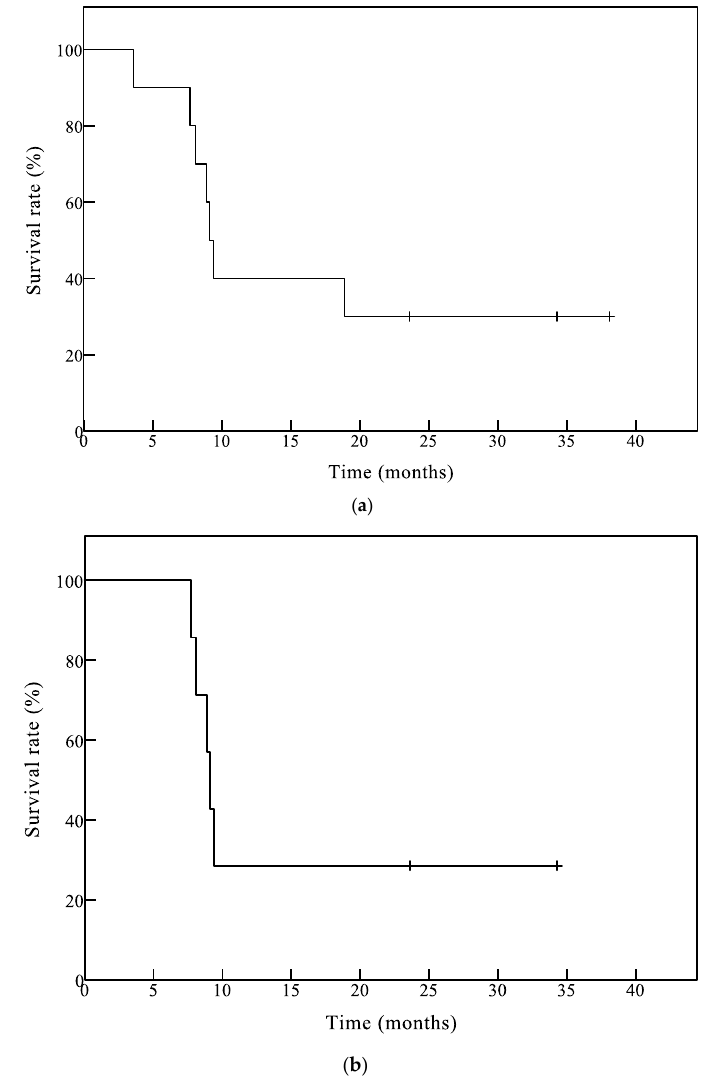
Figure 1. Survival analysis of patients by the Kaplan–Meier method. ( a ) Overall survival (OS) curve of all patients ( n = 10). The median OS time (mOS) of all patients was 9.2 months and 1-year OS was 44.4%; ( b ) OS curve of glioblastoma (GB) patients ( n = 7). The mOS was 9.1 months and 1-year OS was 33.3% in GB